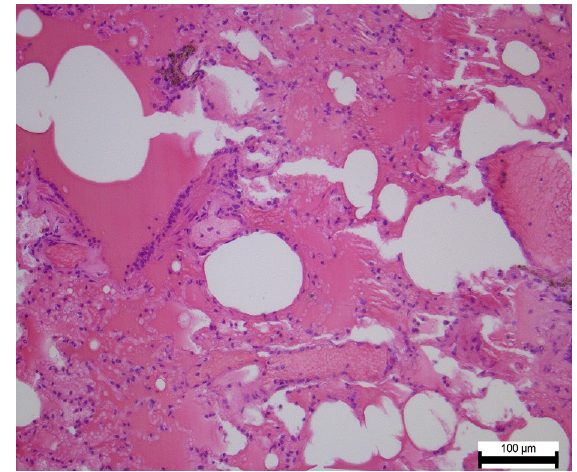
Fig. 11 A. Lungs. Acute congestive hyperemia. Hematoxy- lin and eosin (b). EP 10, lens 20